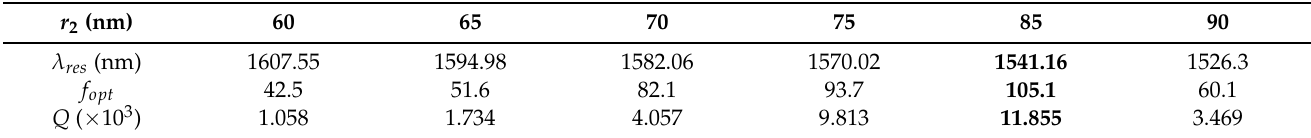
Table 1. Resonance wavelength λ res , Q and f opt varies for different r 2